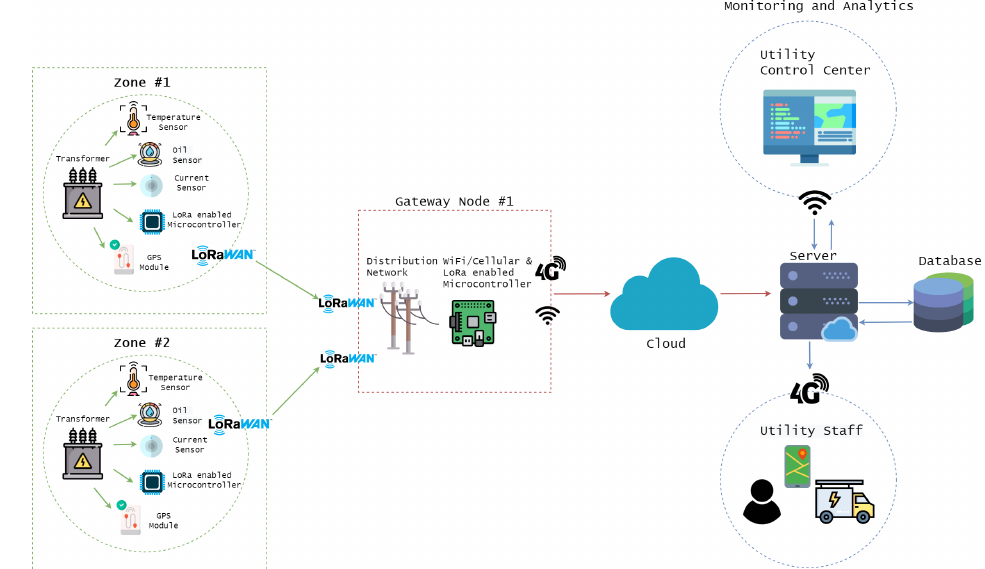
Figure 2. Proposed